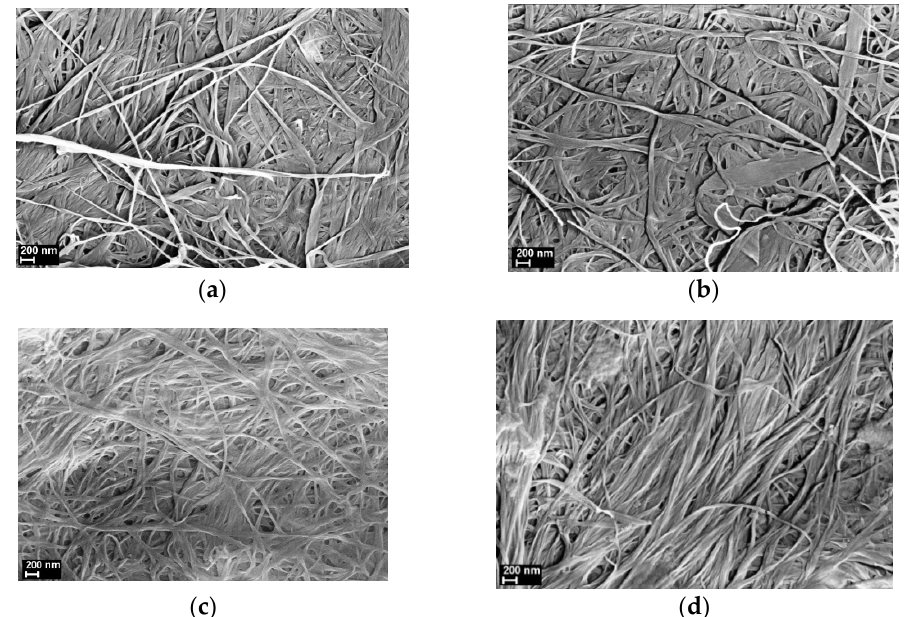
Figure 1. SEM images of the samples studied: ( a ) bare BC; ( b – d ) BC-ceria nanocomposite films containing 1 wt.%, 3 wt.%, and 5 wt.% CeO 2 , respectively.